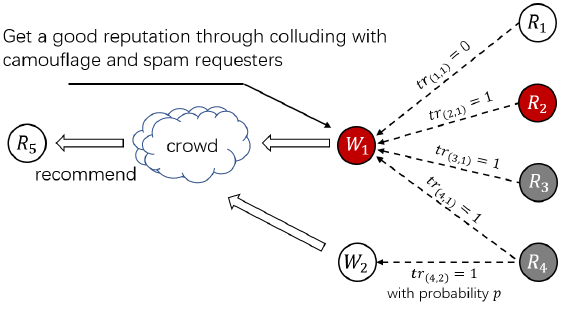
Figure 3. Threat Pattern